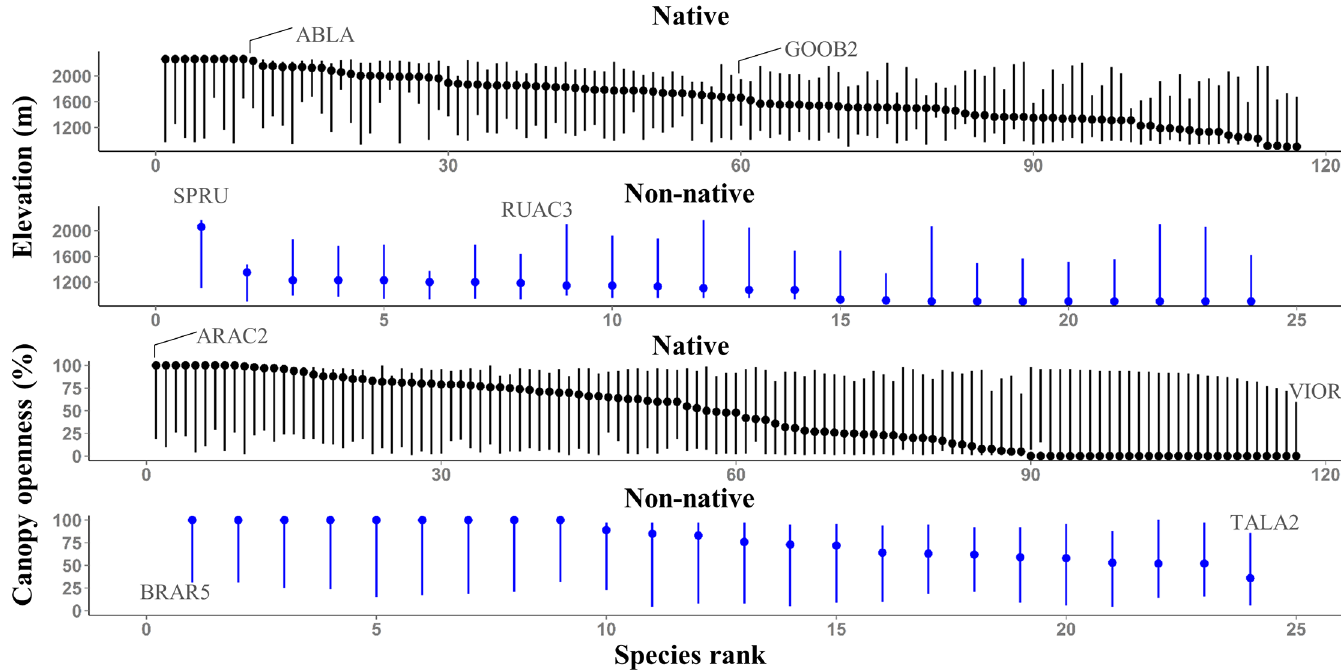
Fig 6. NPMR generated elevation and canopy openness ranges for species (n = 141) included in NMS ordination. Species were ranked by their optima (points) along the elevation and canopy openness gradients. Lines connect between lower (2.5 th percentile) and upper (97.5 th percentile) range boundaries. ABLA ( Abies lasiocarpa ), ARAC2 ( Arenaria aculeata ), BRAR5 ( Bromus arvensis ), GOOB2 ( Goodyera oblongifolia ), RUAC3 ( Rumex acetosella ), SPRU ( Spergularia rubra ), TALA2 ( Taraxacum laevigatum ), VIOR ( Viola orbiculata